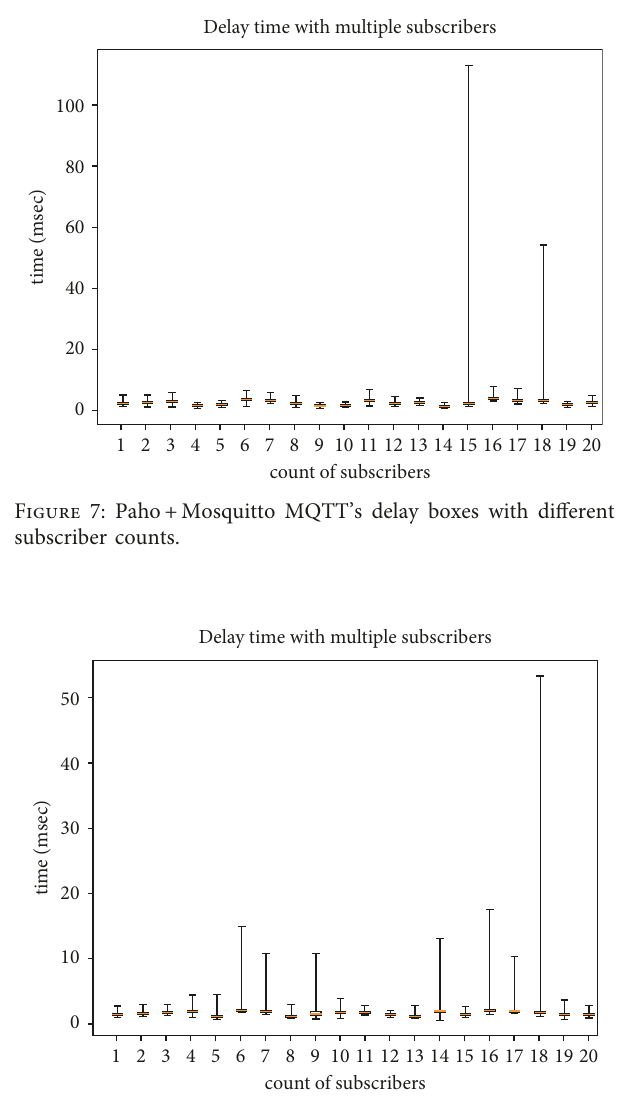
Figure 8: RabbitMQ’s delay boxes with different subscriber